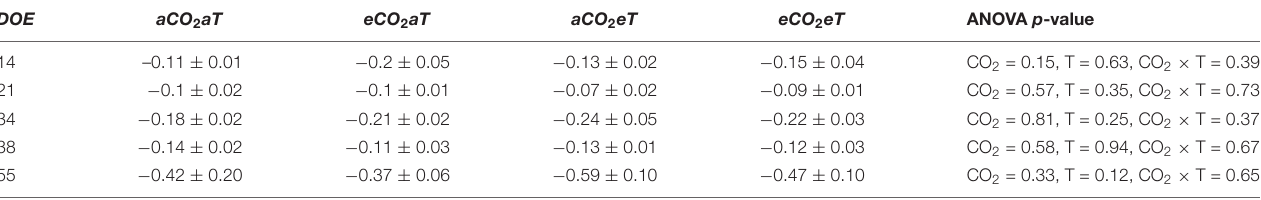
Mean values (n = 4) and standard error ( ± ) are show for every sampling day. [CO 2 ] levels: ambient (aCO 2 ) and elevated (eCO 2 , 600 µ mol mol − 1 ). Temperature levels: ambient (aT) and elevated (eT, + 2 ◦ C above ambient canopy temperature). ANOVA p-value is shown for main effects (CO 2 or T) or interactions CO 2 × T. DOE: day of